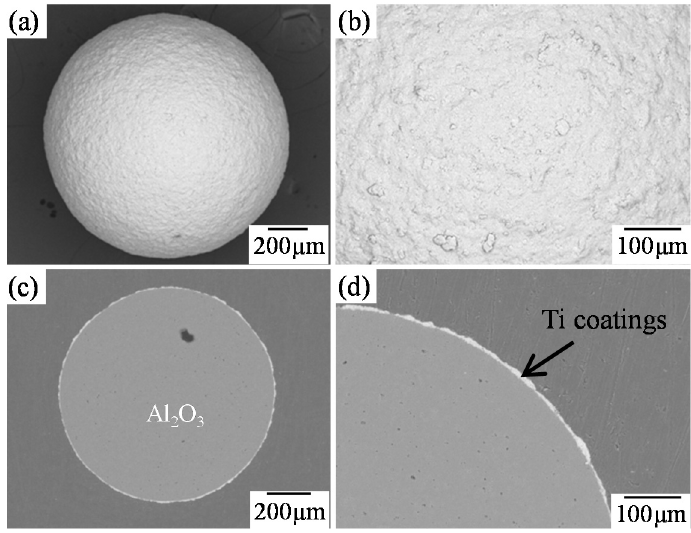
Figure 6. Thickness evolution of Ti coatings with MCT time. ( a ) By pot mill; ( b ) By planetary ball mill.